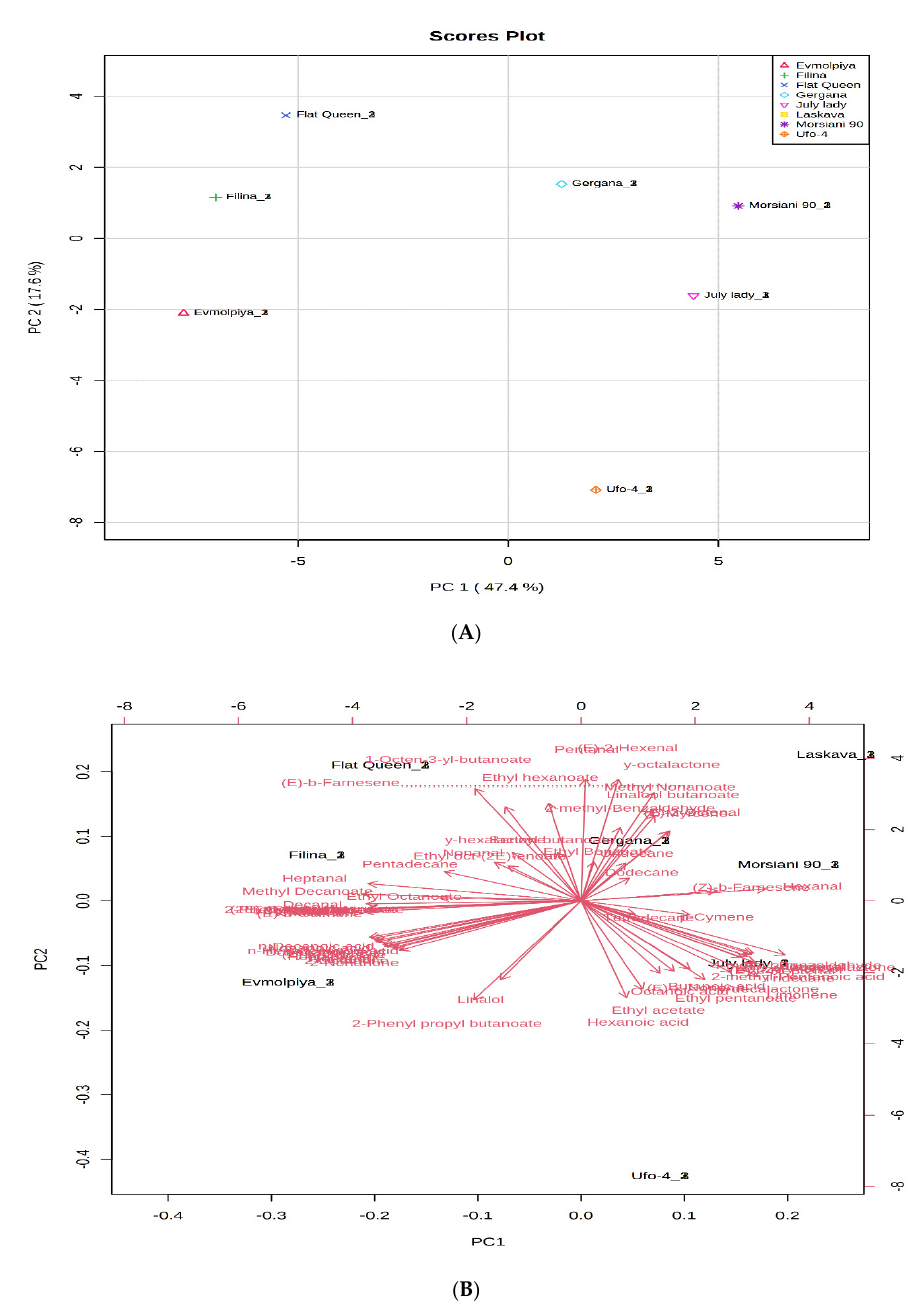
Figure 5. Principal component analysis (PCA) of GC–MS data for volatile compounds of peach ( Prunus persica L.) varieties. ( A ) Principal component score plot for the eight peach varieties. ( B ) Eigenvector loading values of compounds identified in the eight peach varieties. HCA was performed to understand the relationships between the analyzed varieties. According to the dendrogram and heatmap obtained (Figures 6 and 7), the “Filina” variety